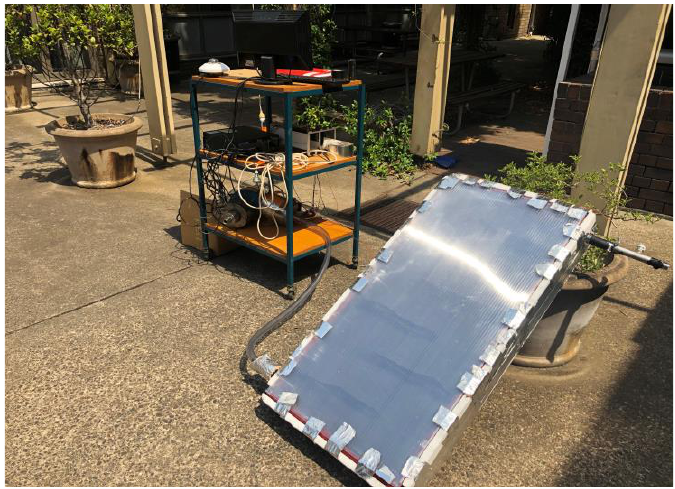
Figure 9. Experimental setup for evaluating performance parameters of SAH.